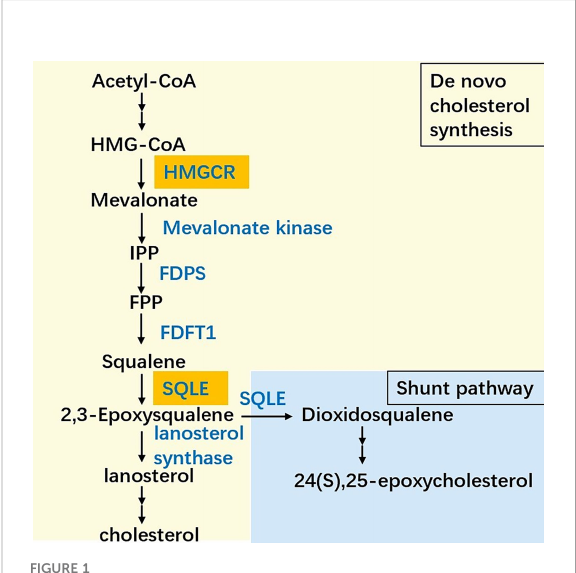
FIGURE 1 The simpli fi ed scheme of cholesterol biosynthesis. The biosynthesis pathway converts acetyl-CoA into cholesterol more than 20 enzymatic reactions, among which HMG-CoA reductase (HMGCR) and squalene epoxidase (SQLE) are the two key speed- limiting enzymes. Besides, SQLE can divert 2,3-epoxysqualene into dioxidosqualene. The end product of the shunt pathway, 24 (S),25-epoxycholesterol can regulate the cholesterol metabolism in turn. IPP: Isopentenyl-PP, FPP: Farnesyl-PP, FDPS: Farnesyl- diphosphate farnesyltransferase 1, FDFT1: Farnesyl-diphosphate farnesyltransferase